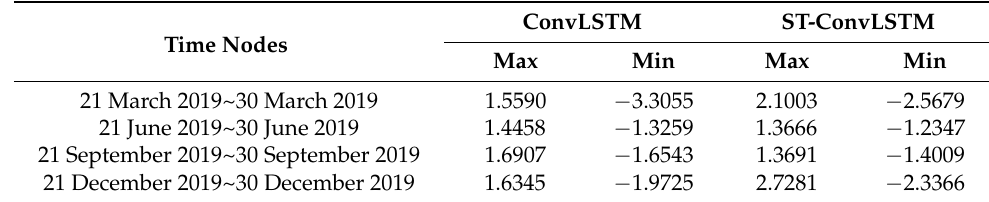
Table 6. The prediction result of SST (Maximum Error and Minimum Error).